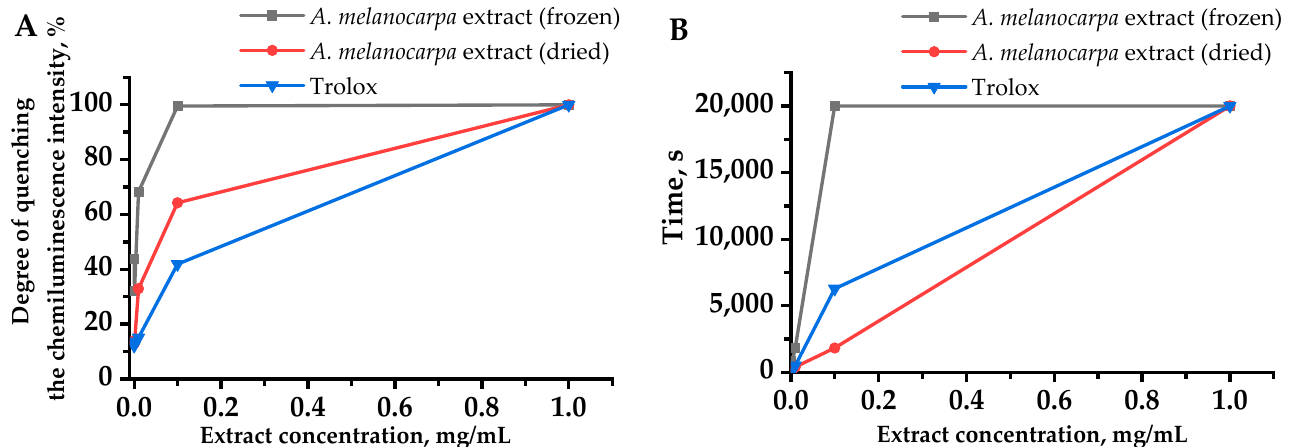
Figure 1. Dependence of TAR (total antioxidant reactivity) values ( A ) and TRAP (total reactive antioxidant potential) values ( B ) on the concentration of extracts obtained from the quenching of luminol-enhanced